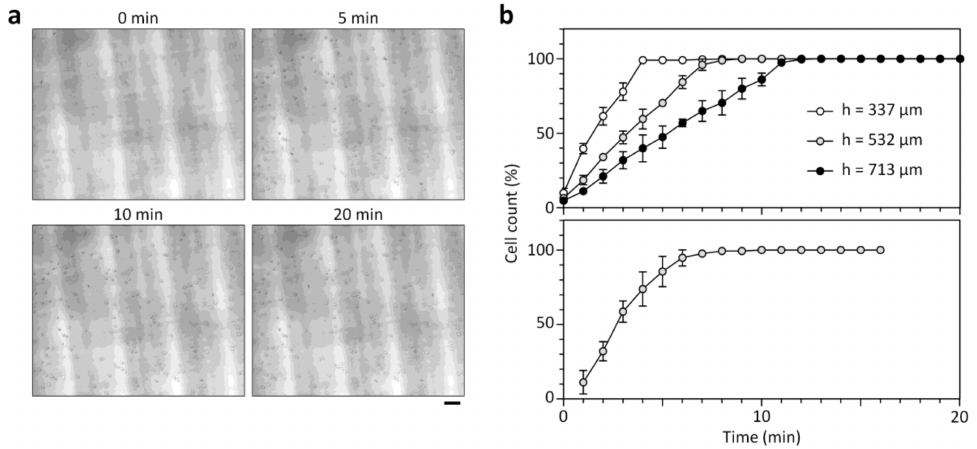
Figure 2. Blood cell sedimentation. ( a ) Successive microscopic images of settling RBCs in the 532- µ m-high microfluidic counting chamber. All out-of-focus or blurry cells right after sample injection come into focus after 10 min. Scale bar, 50 µ m. ( b ) ( top ) The critical time for complete RBC sedimentation depends on the chamber height, and is ≈ 7, 9 and 12.3 min for h c = 337, 532, and 713 µ m, respectively. ( bottom